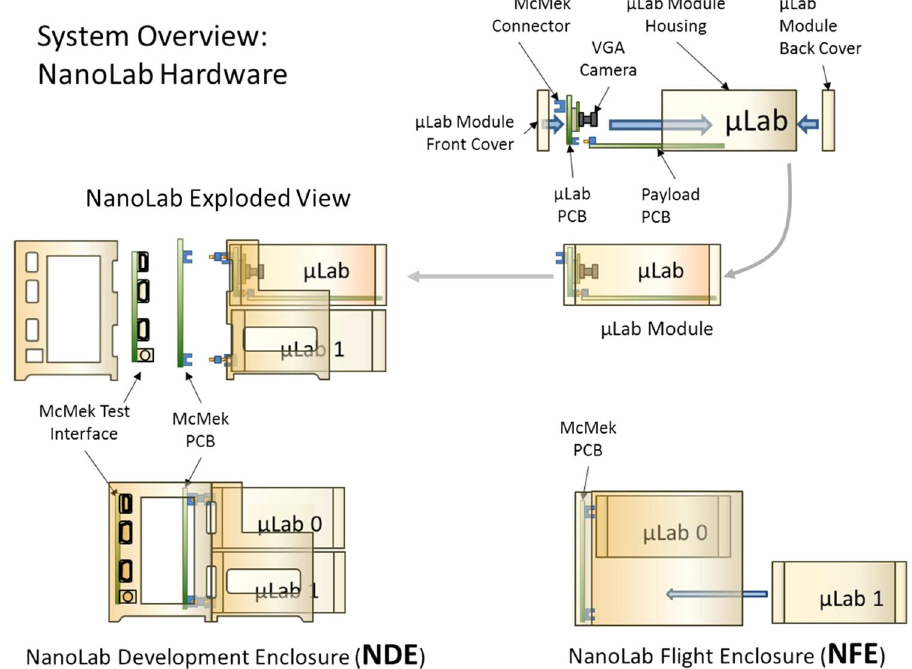
Fig. 1 Development